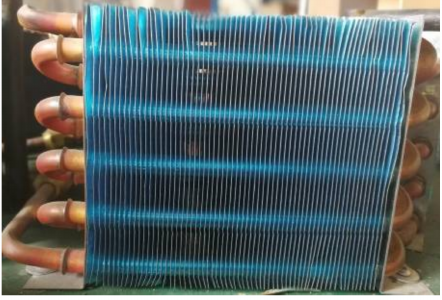
Figure 5. Picture of a radiator.